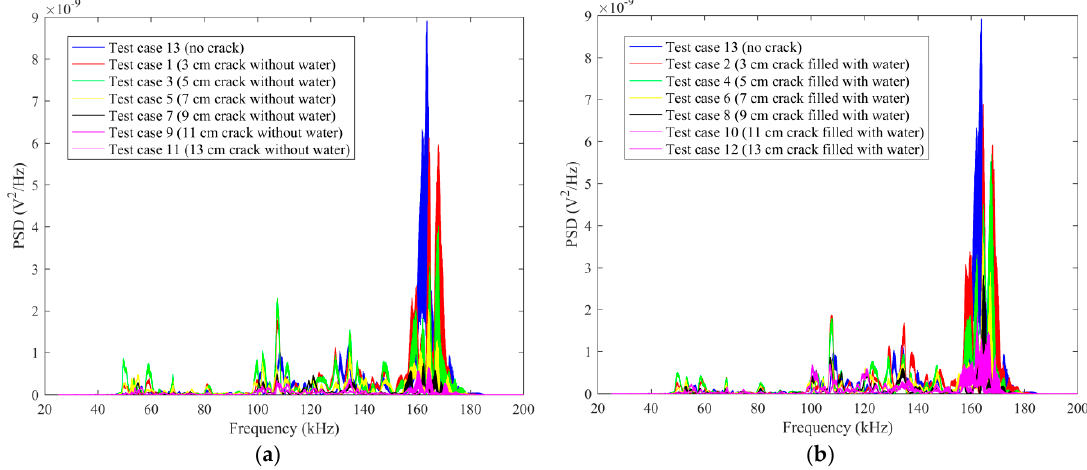
Figure 12. The comparison of PSD energy: ( a ) Test case: no crack and all cracks without water; ( b ) Test case: no crack and all cracks filled with water.